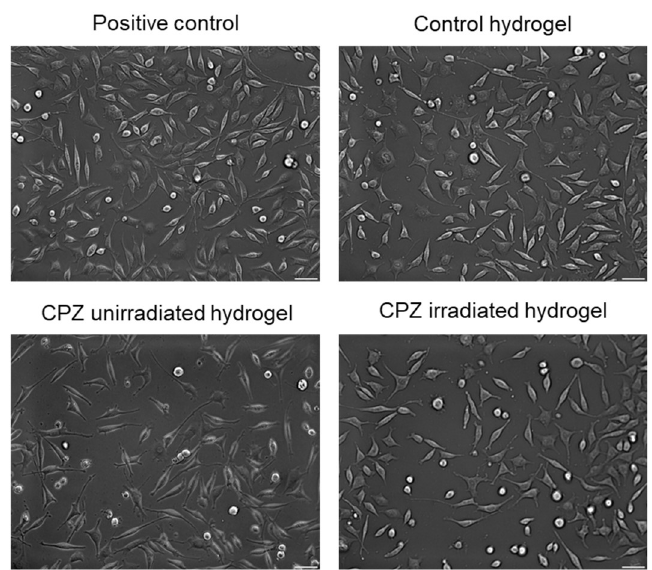
Figure 13. Bright-field images of L929 cells morphology after 24 h exposure to 2 mg/mL unirradiated CPZ and 2 mg/mL irradiated CPZ for 30 min loaded hydrogels in comparison with the positive control; the positive control represents L929 cell in standard culture conditions in the absence of hydrogels; scale set at 20 µm.